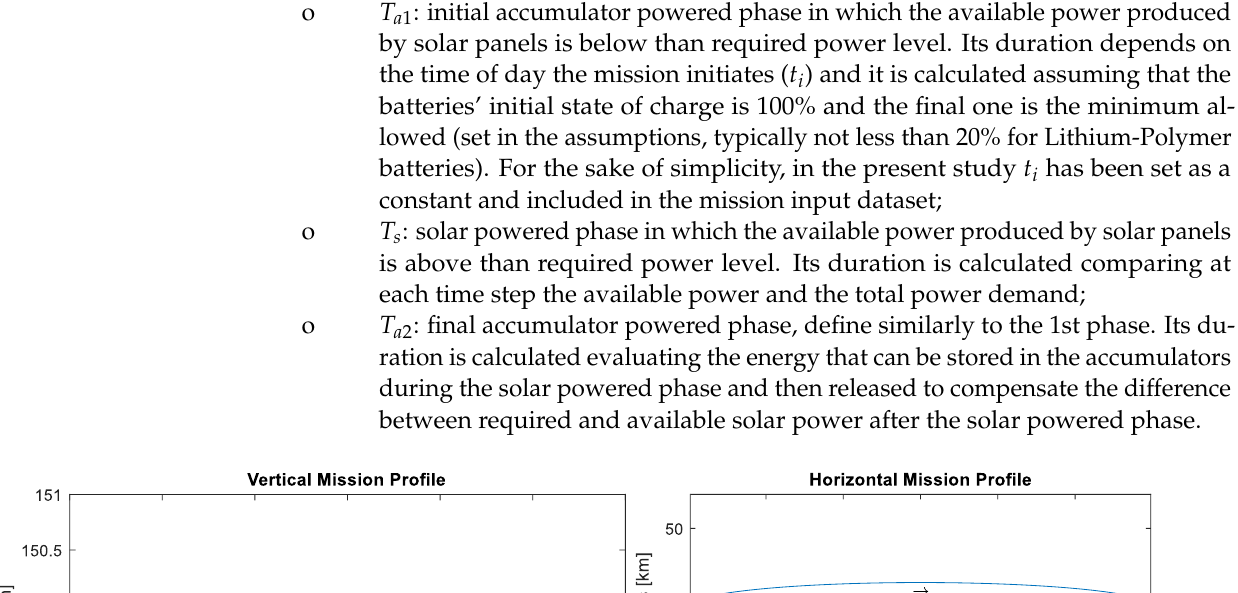
Figure 5. Examples of vertical ( left ) and horizontal ( right ) mission profiles.